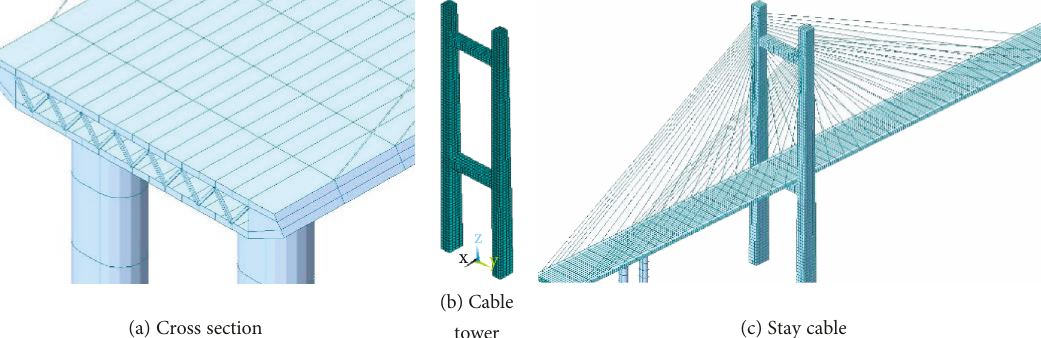
Figure 2: Local mesh model of long-span bridges.